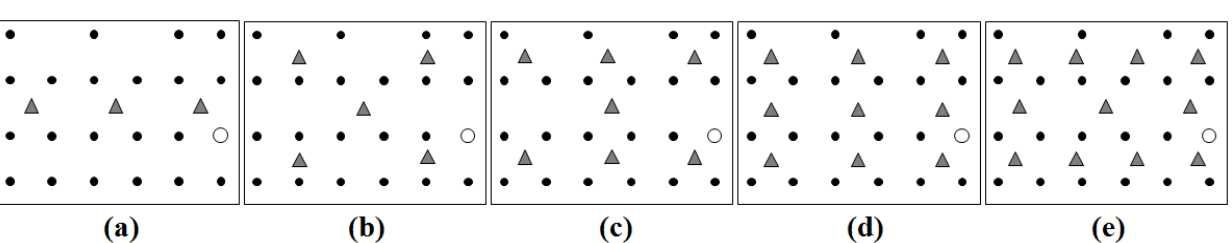
Figure 12. Distribution of sniffers: ( a ) 3 sniffers. ( b ) 5 sniffers. ( c ) 7 sniffers. ( d ) 9 sniffers. ( e ) 11